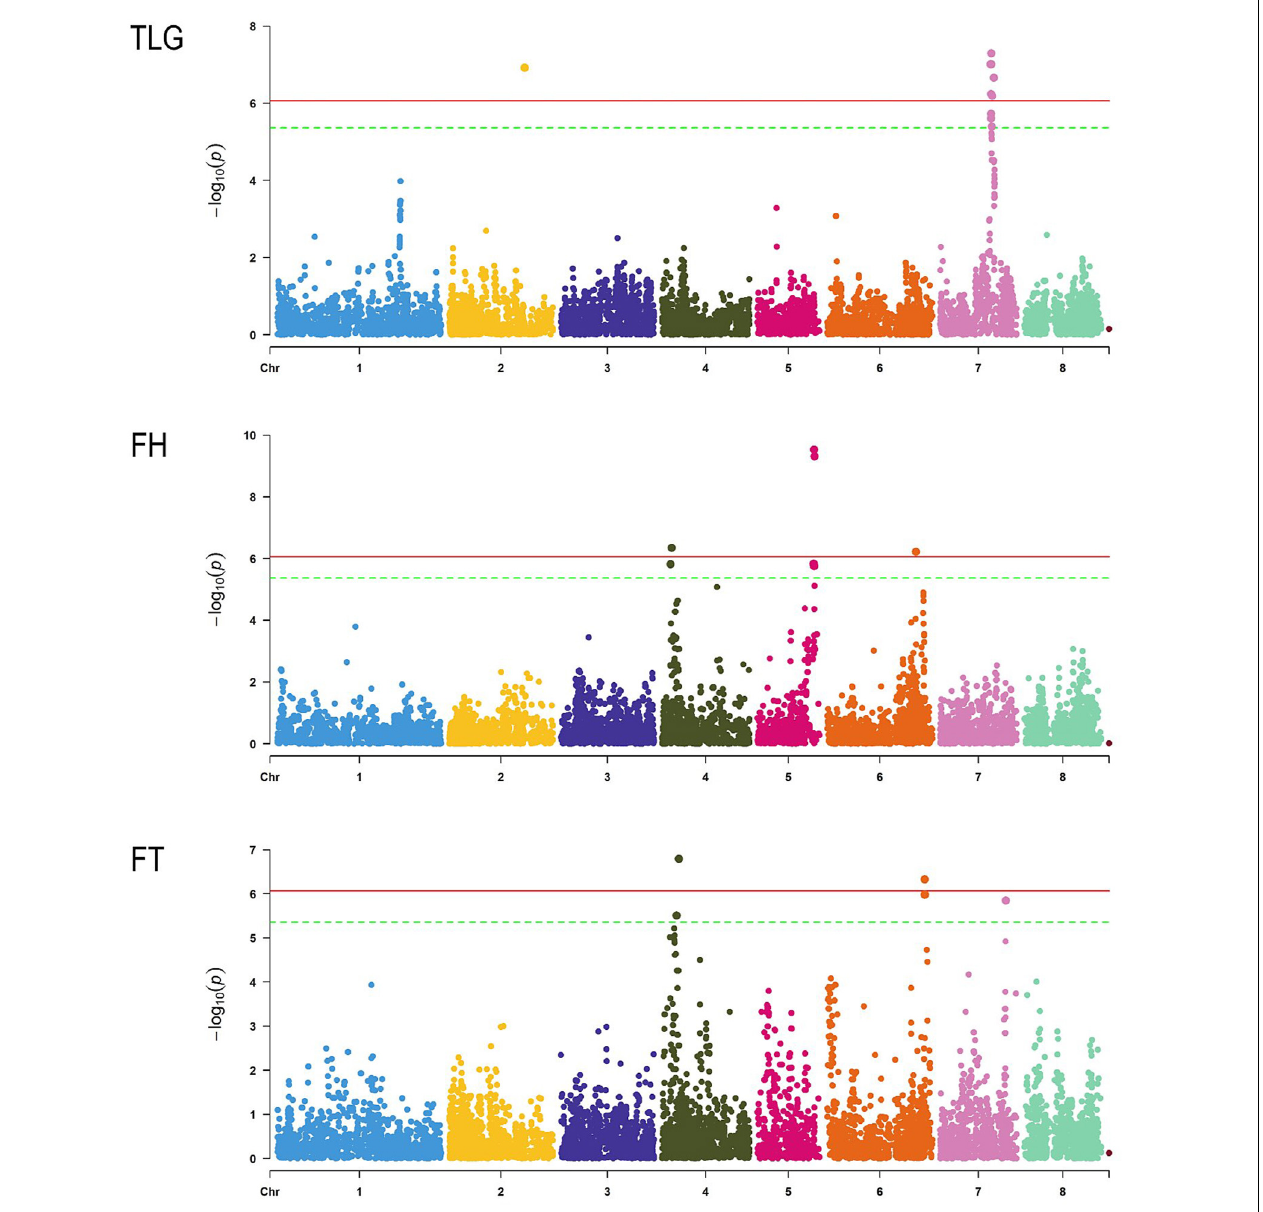
FIGURE 4 | Manhattan plot of each trait studied through GWAS. Chromosomes are represented in the x -axis, the horizontal lines indicate the significance threshold with Bonferroni correction adjusted with α = 0.01 (red) and α = 0.05